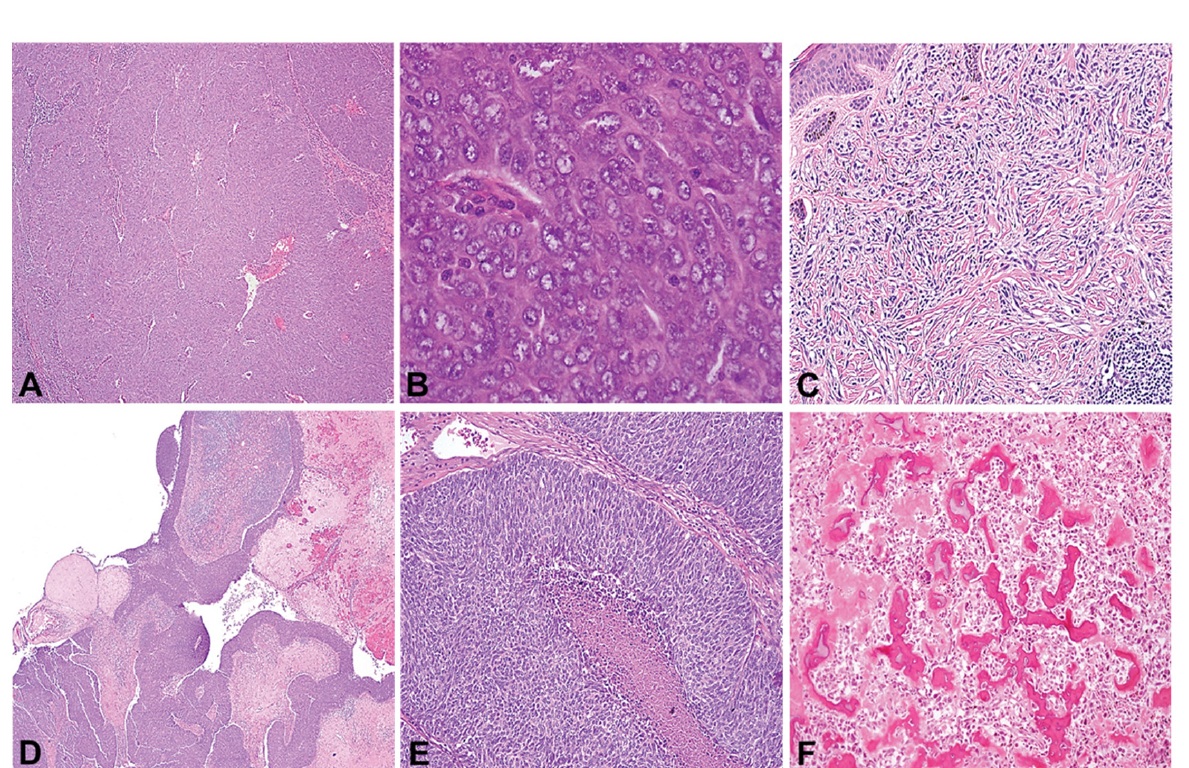
Figure 1. Histological features of thymic carcinomas and associated second cancers. Low ( A ) and high ( B ) magnification of a poorly differentiated thymic carcinoma that was seen in a patient with prior (2 yr) history of spindle cell melanoma ( C ). Low ( D ) and high ( E ) magnification of an unusual papillary cystic thymic carcinoma in a patient with history of osteosarcoma ( F ). Sixteen second cancers had been diagnosed in 14 of these 85 patients (16.5%; Table